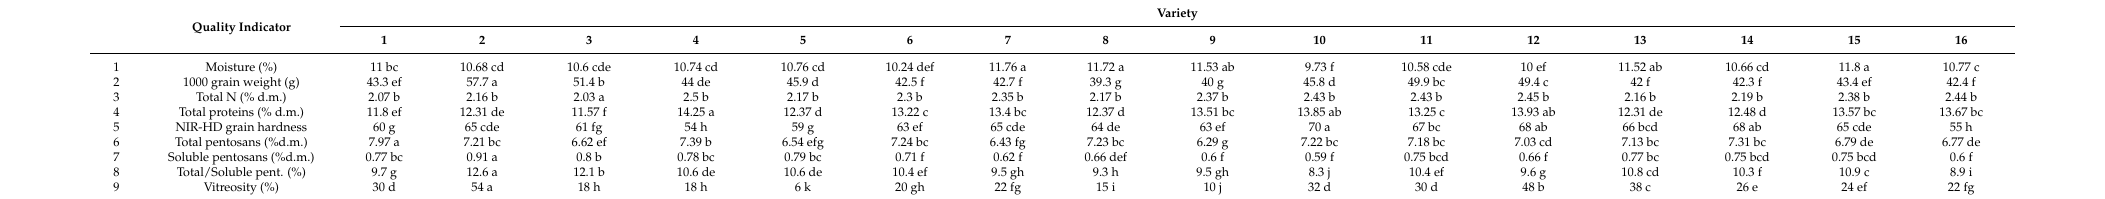
Table 3. Quality characteristics of the used wheat cultivars (harvest 2018).